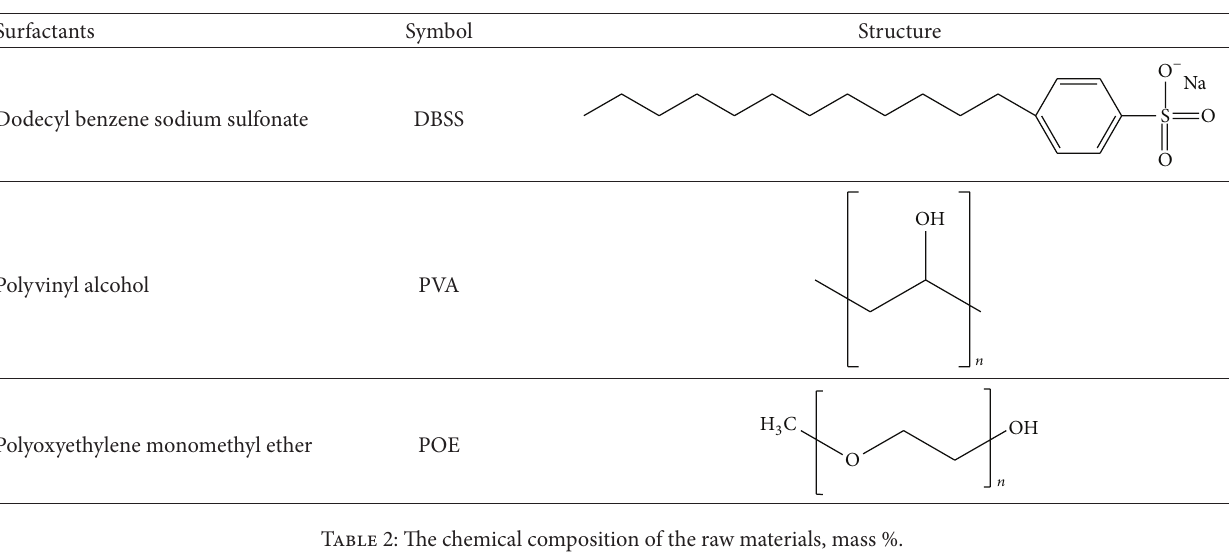
Table 1: The chemical structure of surfactants.